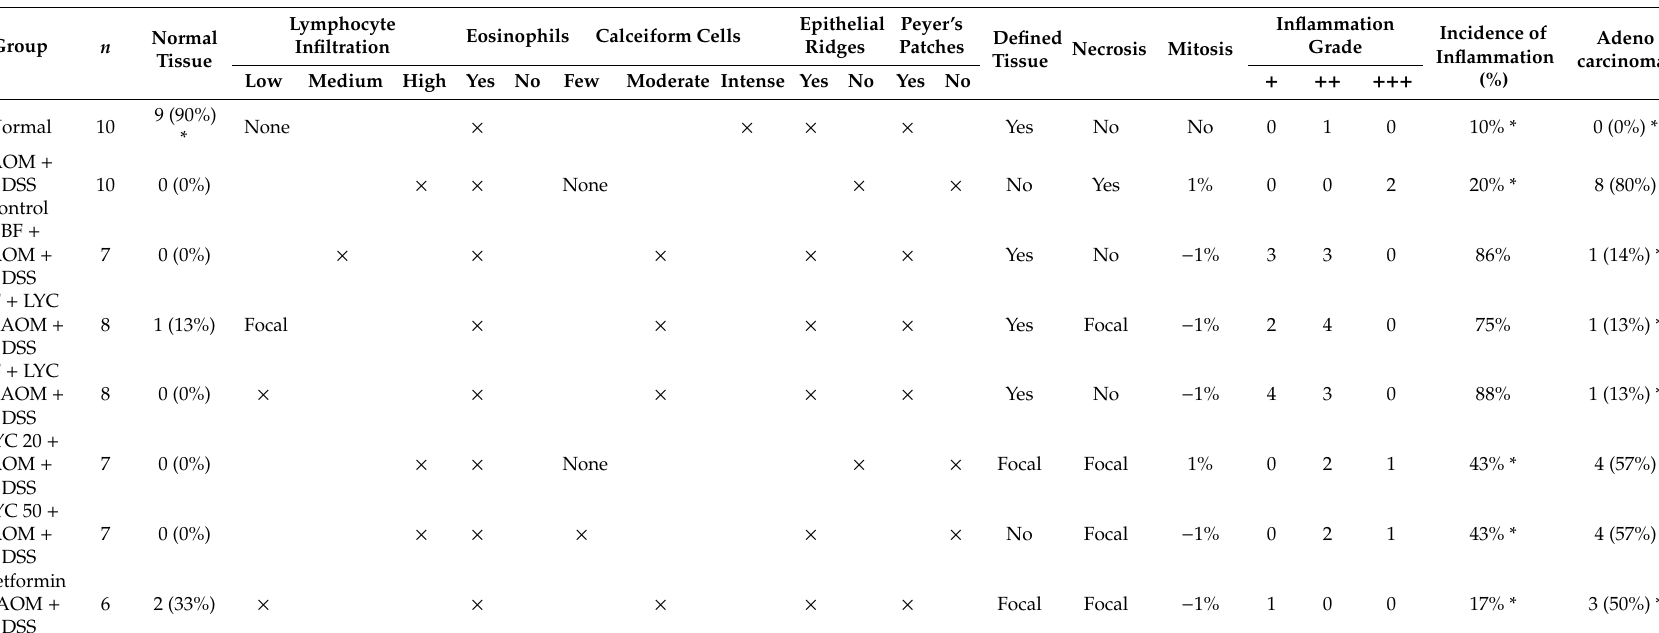
Table 3. Histological features and quantitative classification, according to lymphocyte infiltration, eosinophils, calceiform cells, epithelial ridges, Peyer´s patches, necrosis and mitosis, inflammation grade and adenocarcinomas induced with AOM and DSS in male CD-1 mice. Group